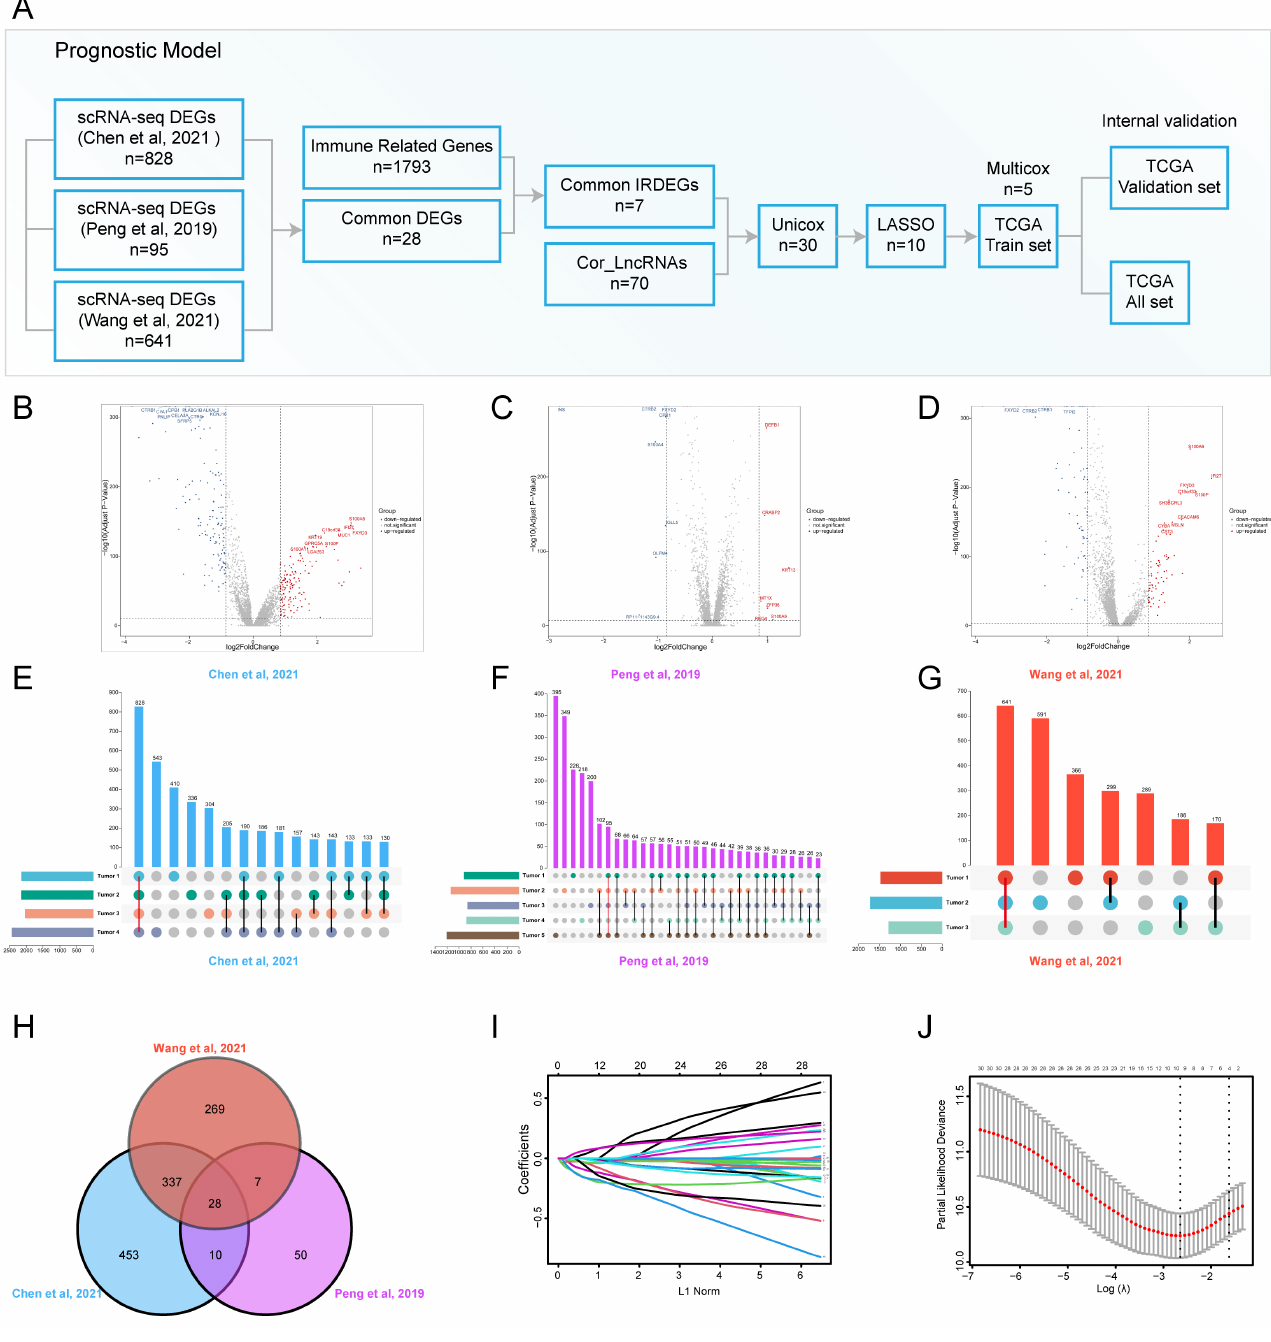
Figure 1. scRNA-seq identified common DEGs for prognostic model construction [9,24,25]. ( A ) Graphical scheme of the construction of the prognostic model; ( B – D ) volcano plots showing the transcriptional profile difference between malignant and normal ductal cells; ( E – G ) common DEGs between malignant and normal ductal cell subpopulations are shown in an Upset plot; ( H ) Venn diagram plot showing DEG interaction among multiple scRNA-seq datasets; ( I , J ) variable selection using the LASSO regression, the correlation between coefficients and the number of variables ( I ), and the first dashed line showing the selected cutoff value, indicating minimal deviance ( J